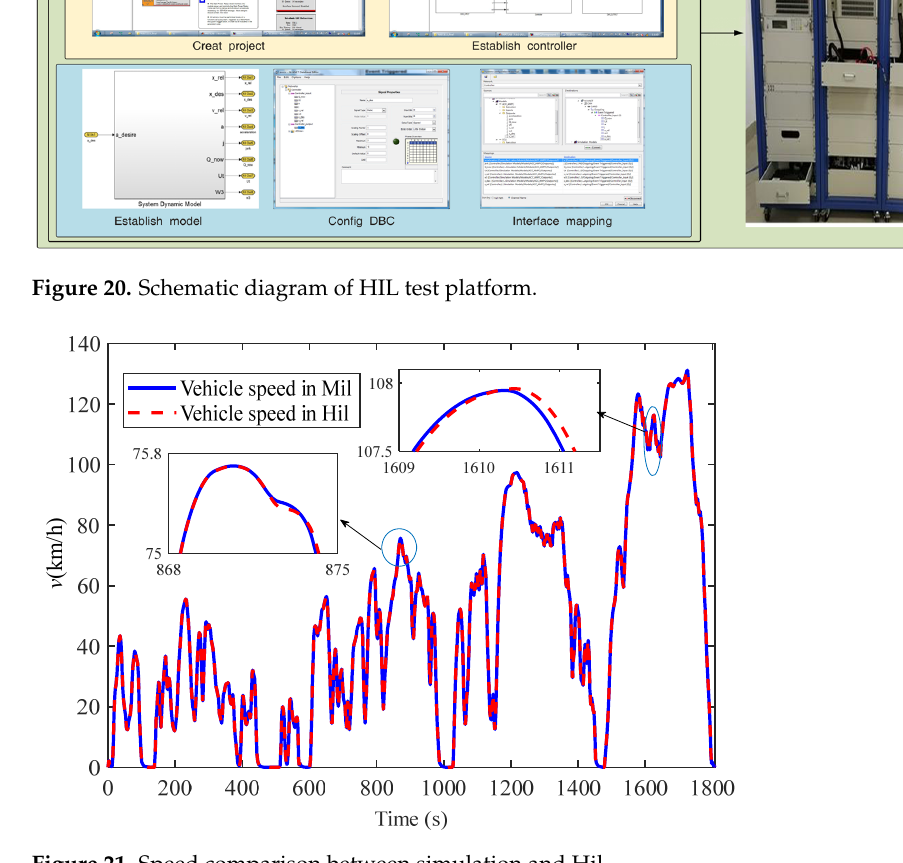
Figure 22. Q loss compariso between simulation and Hil. 5. Conclusions In this paper, a control method that considers the decay characteristics of ba tt ery ca- pacity during tracking is proposed, aiming to extend the service life of the ba tt ery. First a model that can simulate the dynamics of the vehicle system was built, and then perfor- mance indicators that can characterize the driving state, such as comfort, tracking, and economy, were designed. The capacity decay model of the ba tt ery was established through experimental data, and the ba tt ery model was updated accordingly. Then the MPC controller was designed, the cost function was composed by weights and perfor- mance indicators, and the weight was designed by fuzzy control. Finally, the performance of the control method proposed in this study and the traditional controller at di ff erent ba tt ery SOH, di ff erent working conditions and di ff erent cycle times was veri fi ed by sim- ulation. After the results were analyzed, it was seen that the follow-up control method which is proposed in this paper, and which considers the aging characteristics of the bat-